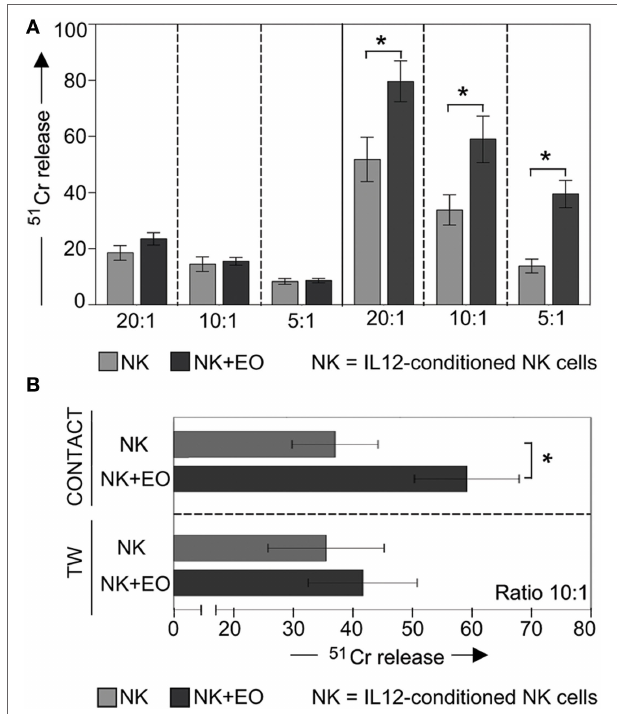
FigUre 3 | anti-tumor cytolytic activity of nK cells cocultured with fresh eosinophils (eOs) . (a) Resting NK cells (left) or IL12-conditioned NK cells (right) were cultured o.n. with EOs at an E : T ratio of 1:1; then harvested and analyzed for cytolytic activity against K562 at various E : T ratios. Gray bars refer to lysis by NK cells cultured alone, black bars represent lysis by NK cells cocultured with EOs. The average of six independent experiments is shown (% ± SD). * P < 0.05. (B) IL12-conditioned NK cells were cocultured with EOs, either in the presence of cell-to-cell contact (top) or in transwell (bottom). After o.n. culture, NK cells were harvested and analyzed for cytolytic activity against K562 at E : T ratio of 10:1. Gray bars refer to lysis by NK cells cultured alone, black bars represent lysis by NK cells cocultured with EOs. The average of six independent experiments is shown (% ± SD). * P <